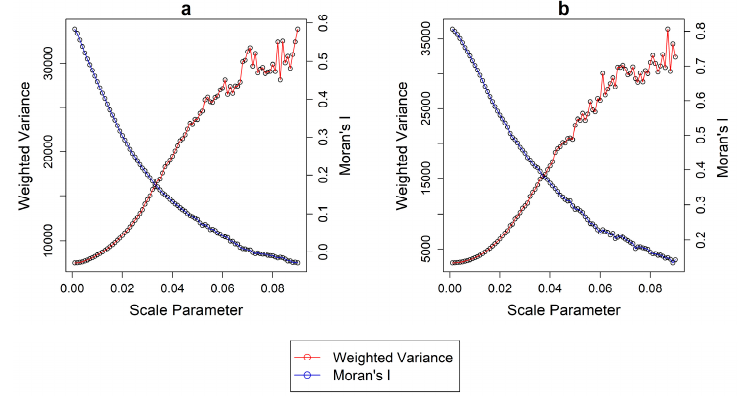
Figure 2. MI and WV values for each computed segmentation for ( a ) ROI 1 and ( b ) ROI 2.